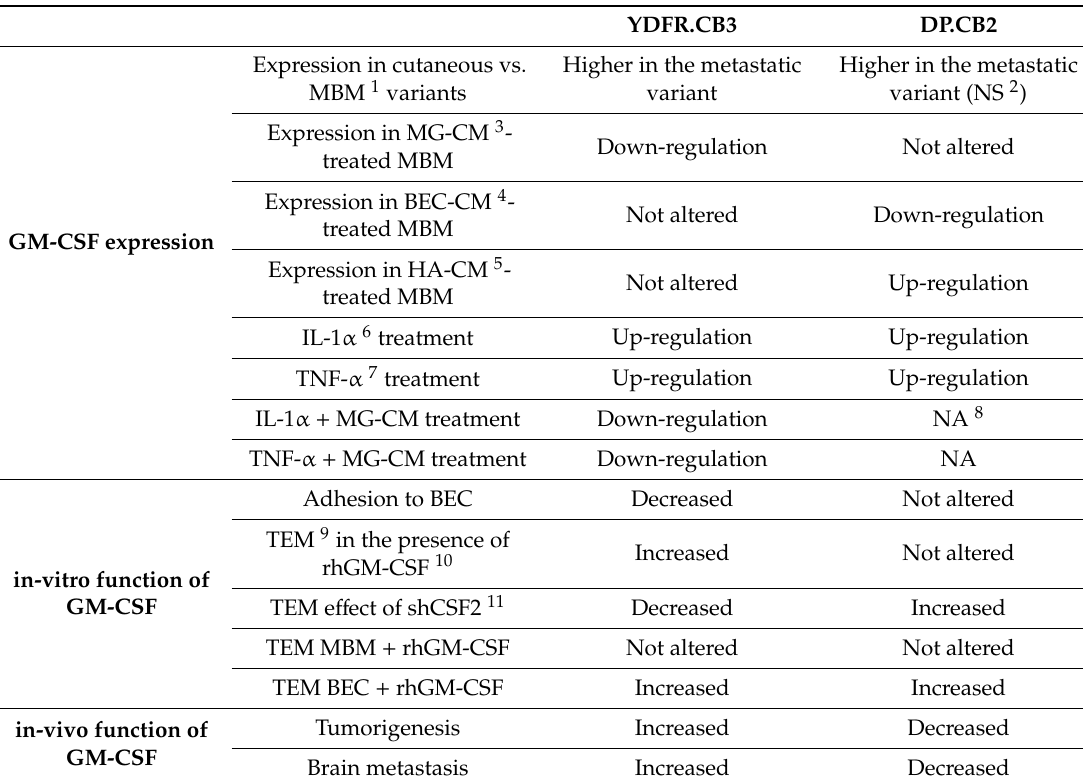
Table 2. The impact of GM-CSF on the brain metastatic melanoma cells YDFR.CB3 and DP.CB2.